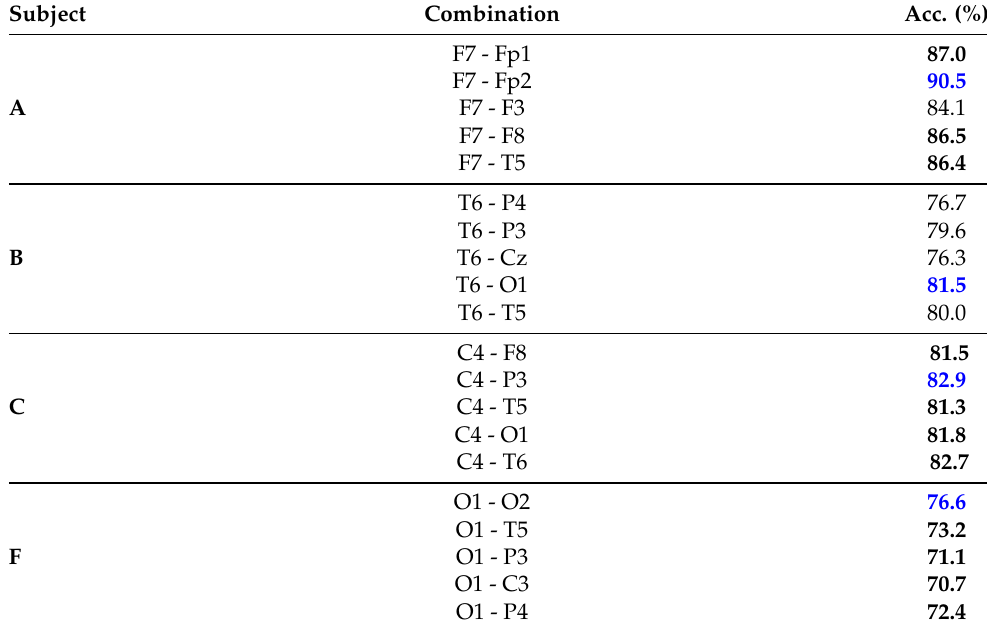
Table 5. Classification accuracies achieved for each 2-channel combination.